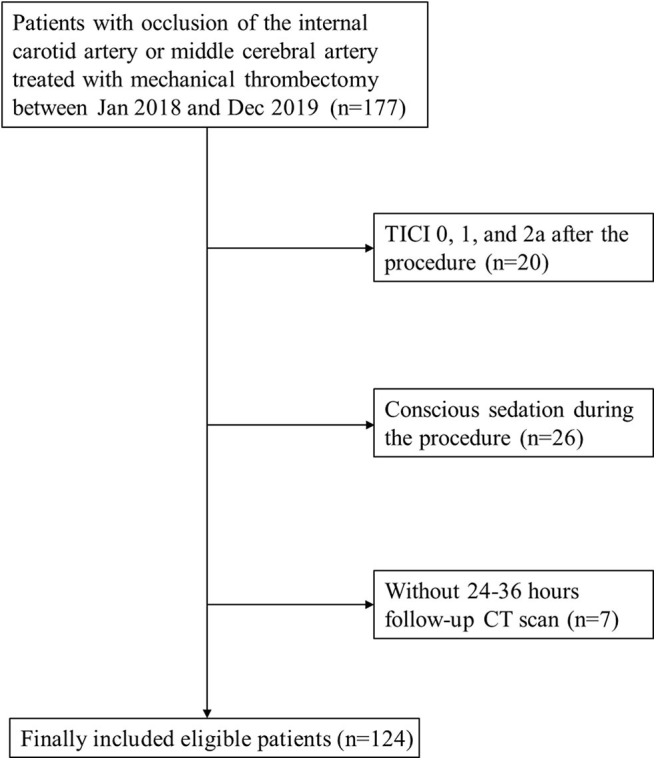
Patient flow chart.